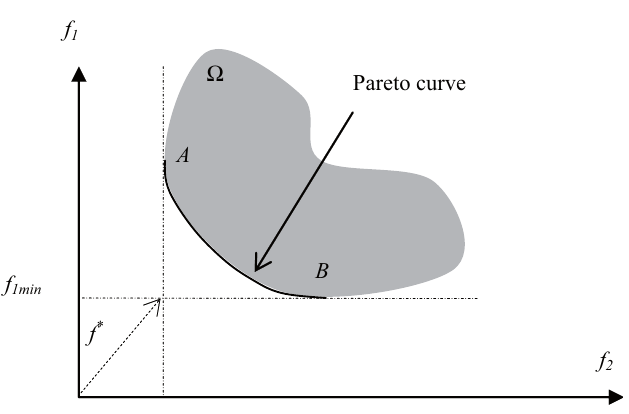
Fig. 1. Pareto curve (Min ( f 1 and f 2 )).